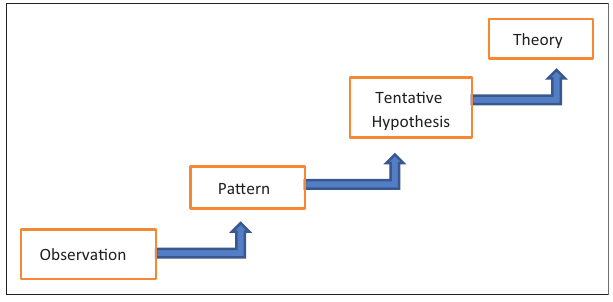
FIGURE 3: Research methodology.